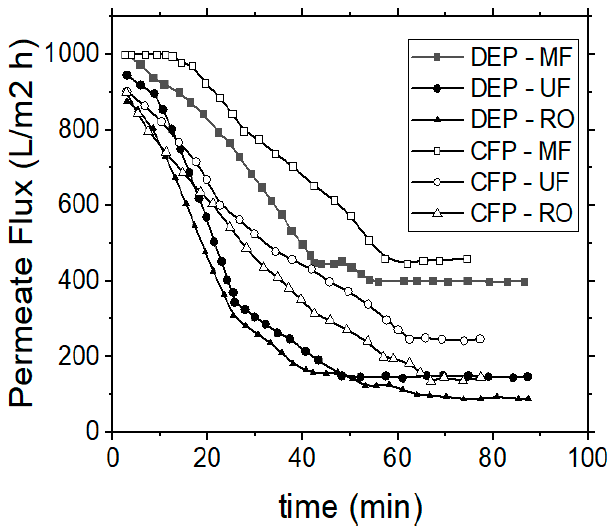
Figure 9. Treatment of real industrial tannery wastewaters; permeate flux variation vs. operational time during dead-end (DEP) or cross-flow (CFP) operation modes.